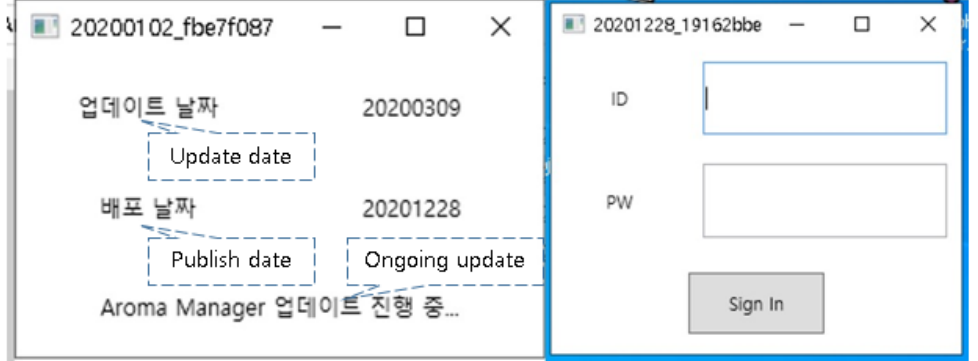
Figure 3. Log-in pop-up window of the manager program.